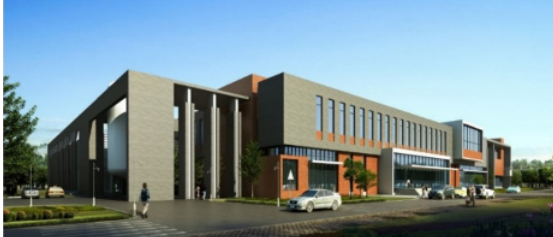
Fig. 1. Data centre